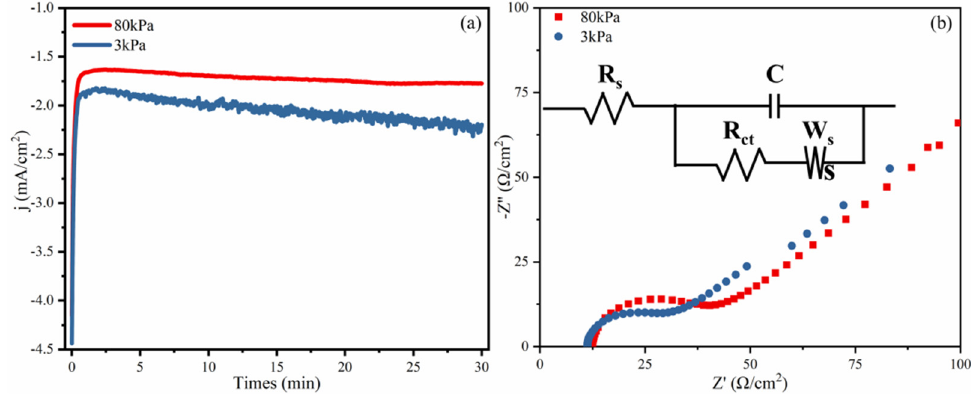
Figure 5. The ( a ) current density − time curve and ( b ) impedance Nyquist plot of electrodeposition CIGS thin films at 3 kPa.